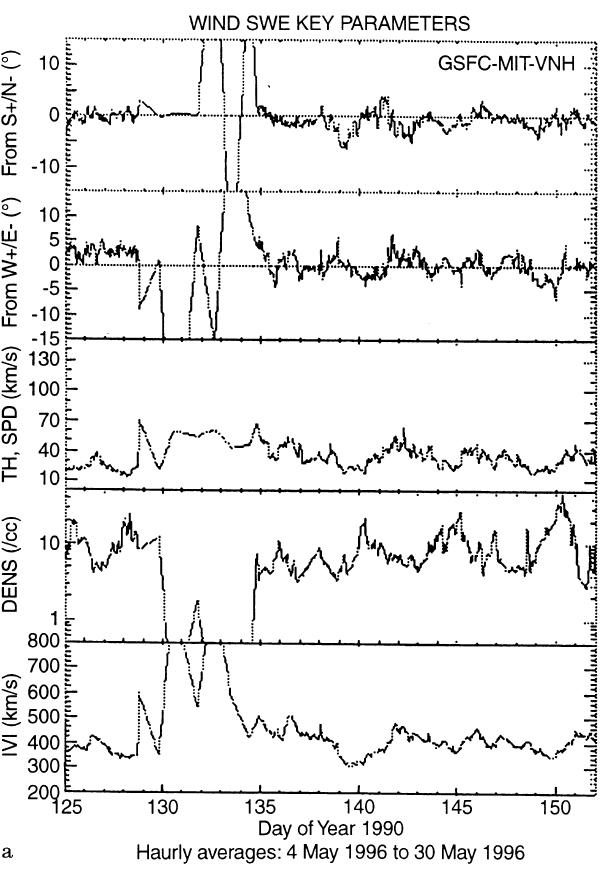
Fig. 13. a Measurements of solar wind parameters at 1 AU (215 R ) from the Wind spacecraft, 4 May 1996–30 May 1996. The compression region observed by EISCAT on 22 May 1996 intersected the orbit of the Wind spacecraft between day 149 and day 151 of the year–29 (30 May), when Wind detected the intermediate flow velocities ( (cid:24) 450 km s ) 1 ) and enhanced densities characteristic of an